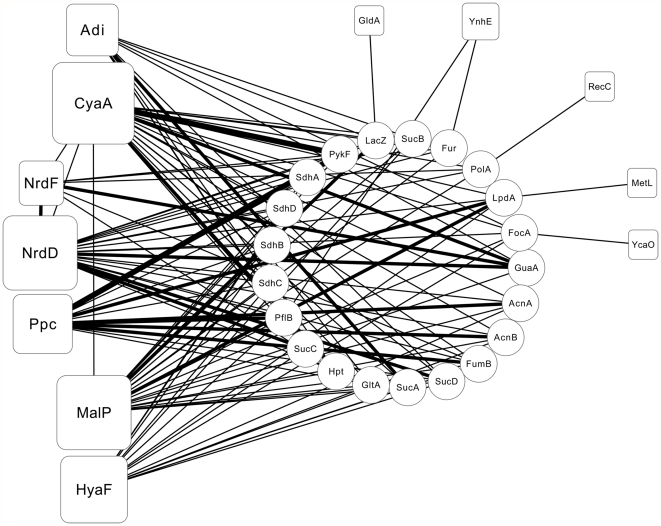
The functional interaction network of the 16 target proteins identified from the fluorescence polarization assays.Each square shape represents the target proteins identified from the FP assays, and round shapes represent the interacting proteins. The EcID was used to find the interacting proteins of these 16 targets. Here, we showed only the proteins that interact with at least 5 targets, and 21 interacting proteins were identified. The thicker line symbolizes that more databases show that they have an interaction between 2 proteins. Seven out of the 16 target proteins, NrdD, CyaA, MalP, Adi, NrdF, Ppc and HyaF, have more interactions and are considered to be hubs.